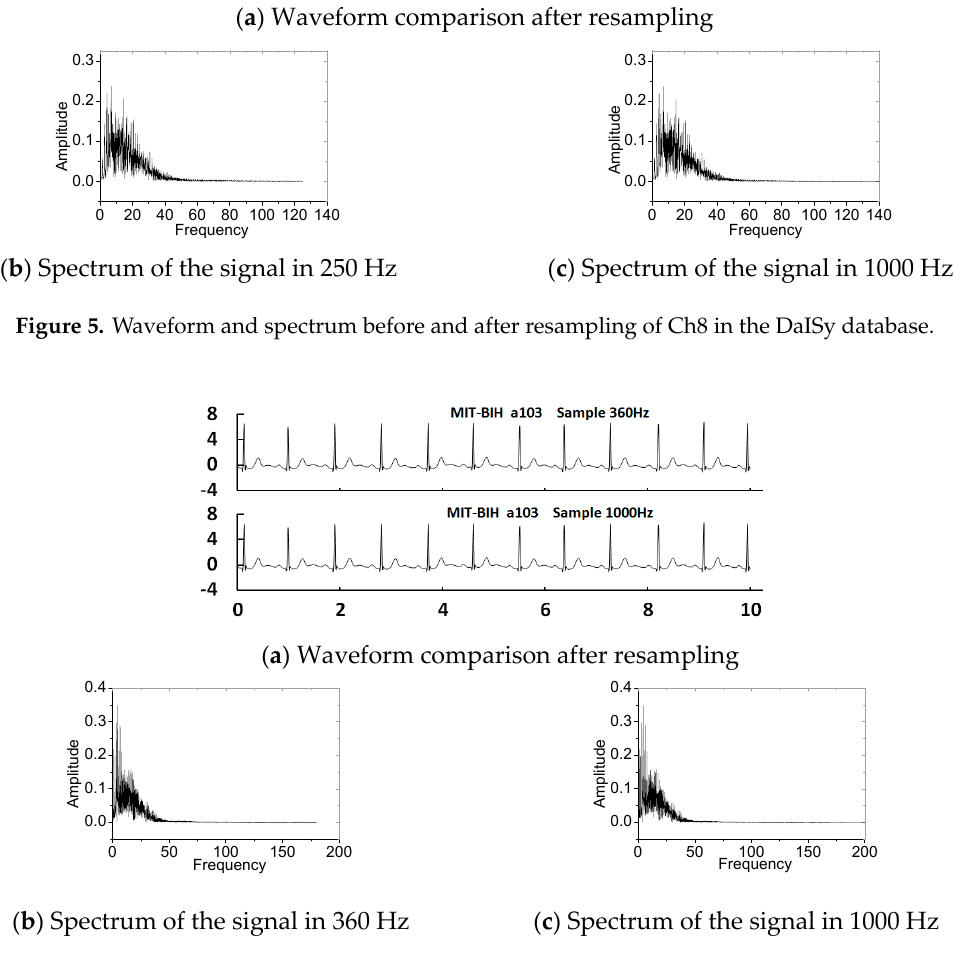
Figure 6. Waveform and spectrum before and after resampling of a103 in the MIT-BIH database.